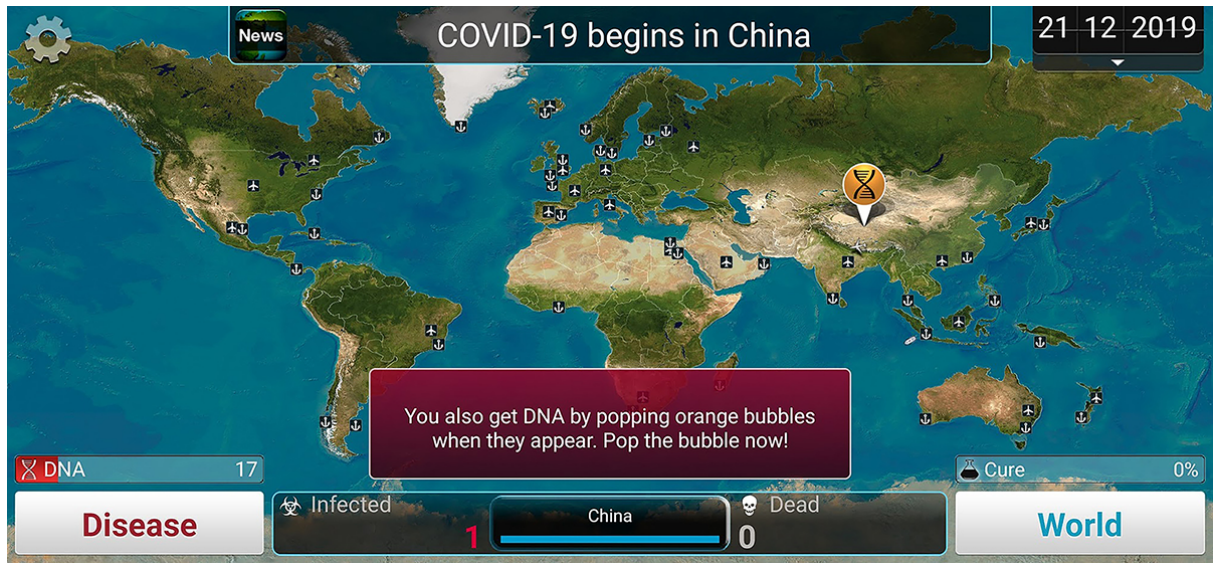
Figure 1. Game guild levels of Plague